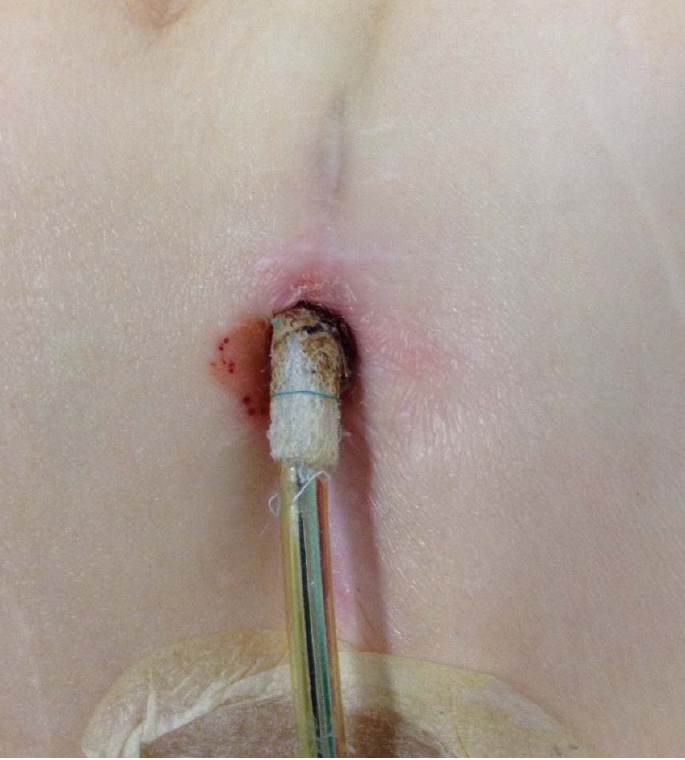
Figure 1. Typical appearance of petechial hemorrhages in the skin around the exit site in VAD driveline